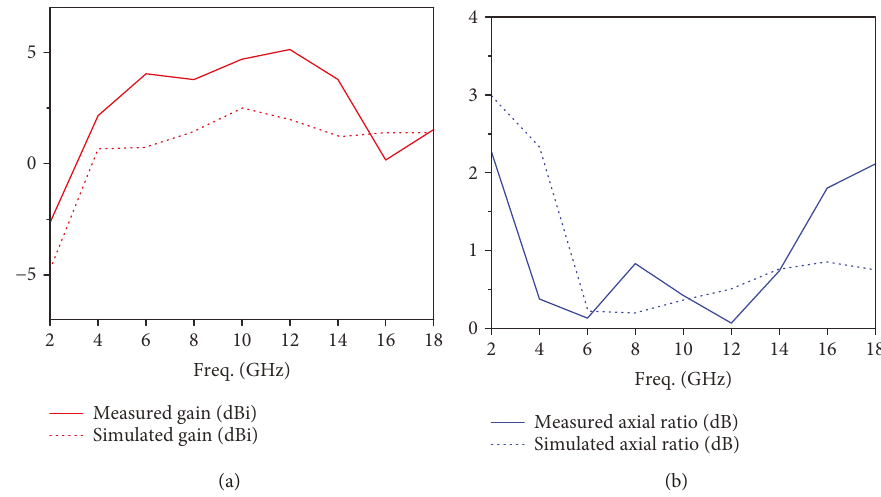
Figure 8: Comparison of measured and simulated (a) gain and (b) axial ratio.